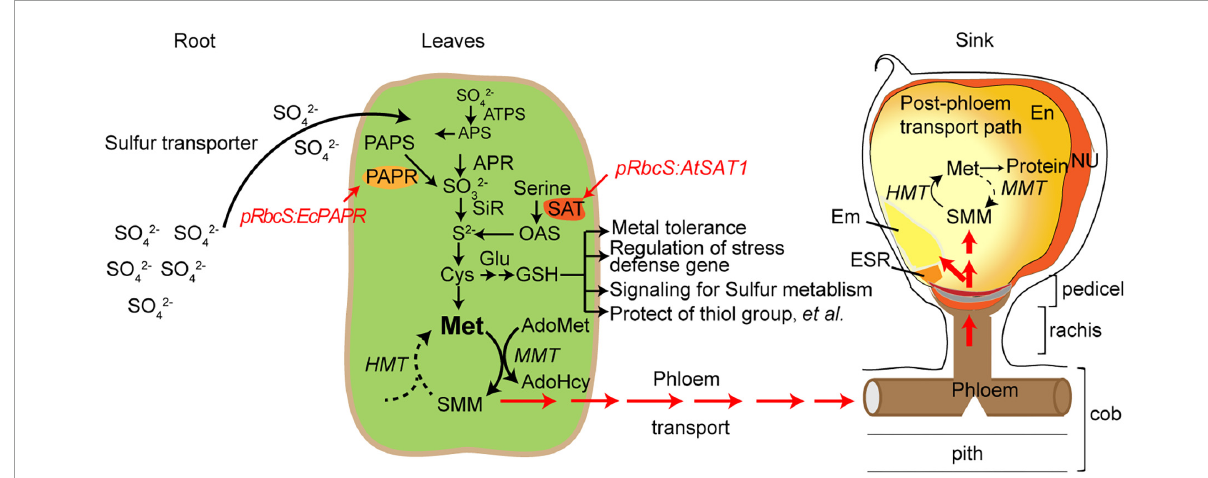
FIGURE8 Schematic diagram of sulfur pools in developing maize seeds. SO 42 – , sulphate; SO 32 – , sulfite; S 2 – , sulphide; ATP-S, ATP-sulfurylase; APS, adenosine 5 (cid:48) - phosphosulfate; APR, APS reductase; SiR, sulfite reductase; SAT, serine acetyltransferase; OAS-TL, O-acetyserine(thiol)lyase; OAS, O-acetylserine; PAPR, 3 (cid:48) -phosphoadenosine-5 (cid:48) -phosphosulfate reductase; PAPS, 3 ’ -phosphoadenosine-5 ’ -phosphosulfate; Cys, cystenine; Glu, glutamate; GSH, reduced glutathione; Cys, cysteine; Met, methionine; HMT: Homocysteine S-methyltransferase, SMM, S-methylmethionine; MMT, methionine S-methyltransferase; AdoMet, S-Adenosyl-l-methionine; AdoHcy, S-adenosylhomocysteine; En, endosperm; Nu, nucellus; ESR, embryo-surrounding region; and BETL, basal endosperm transfer cell